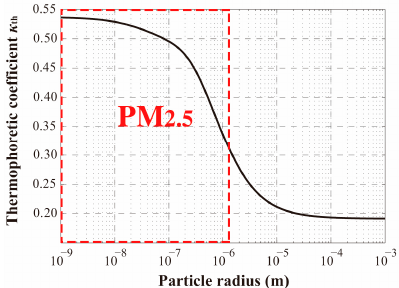
Figure 7. Thermophoretic coefficient K th with different particle radius R in a semi-logarithmic coordinate.